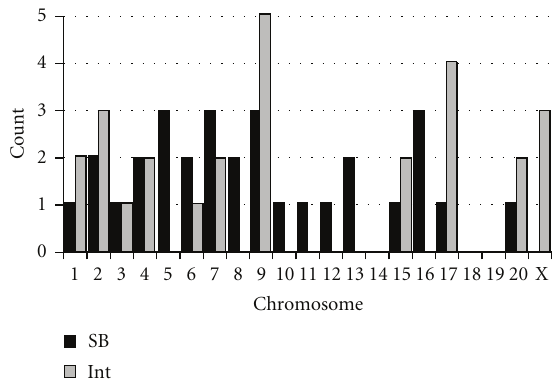
Figure 6: Chromosomal distribution of SB and φ C31 integrants. Integrants with flanking sequence were recovered from the genome of MAPC by either linker-mediated PCR (SB; grey bars) or plasmid rescue ( φ C31; black bars); the frequency and distribution of independent events is